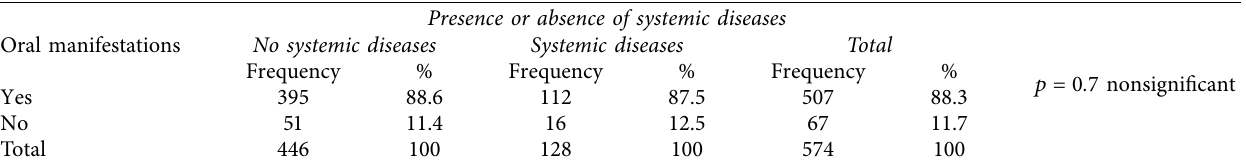
Table 3: Frequency, percentage, and the statistical diference of occurrence of oral symptoms in COVID-19 patients according to their medical condition.